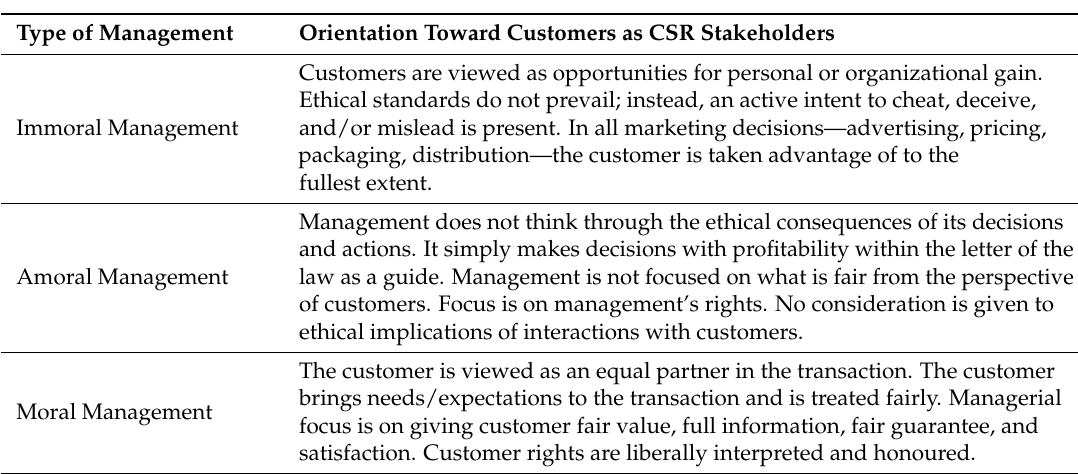
Table 1. Types of business management with respect to consumers as CSR